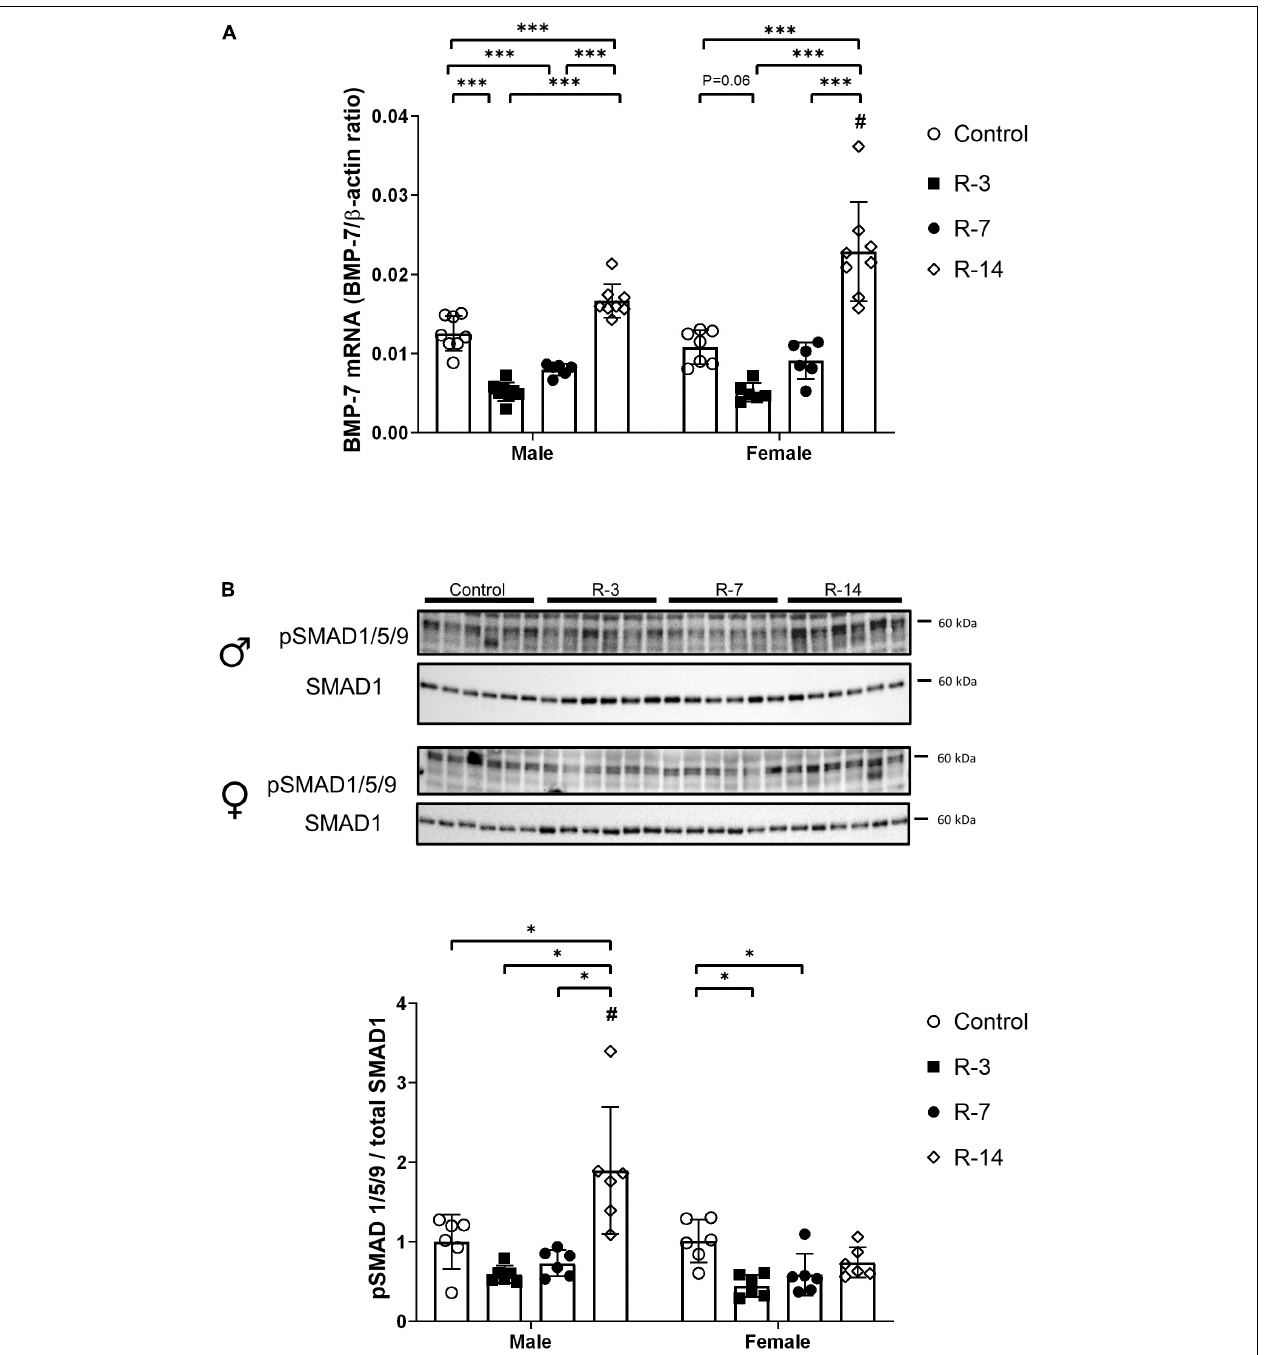
FIGURE 6 | Activation of the BMP-7/SMAD1/5/9 signaling after release of 24 h total bladder outlet obstruction. (A) BMP-7 mRNA expression was decreased at 3 and 7 days post release, followed by increased levels at 14 days post release. In female mice, BMP-7 mRNA expression showed a tendency to decrease at 3 days post release, while at 14 days post release increased BMP-7 expression was observed. The BMP-7 mRNA expression in the male R-14 group was lower than that in the female R-14 group. Relative mRNA expression was calculated using the reference gene β -actin ( n = 8, 8, 6, and 8 in the male control, R-3, R-7, and R-14 group, respectively; n = 7, 6, 6, and 8 in the female control, R-3, R-7, and R-14 group, respectively). (B) Representative Western blots related to SMAD signaling showing increased phosphorylation of SMAD1/5/9 in the male mice at 14 days post release. The pSMAD1/5/9 protein level in the male R-14 group was higher than that in the female R-14 group. Decreased phosphorylation of SMAD1/5/9 was found at 3 and 7 days post release in the female mice. pSMAD1/5/9 was normalized by total SMAD1. Quantification of protein expression relative was normalized by total protein ( n = 6 in all groups). Male, Female. Data are presented as means ± SD. ∗ P < 0.05 and ∗∗∗ P < 0.01. # P < 0.05 compared between genders with the corresponding ♂ ♀